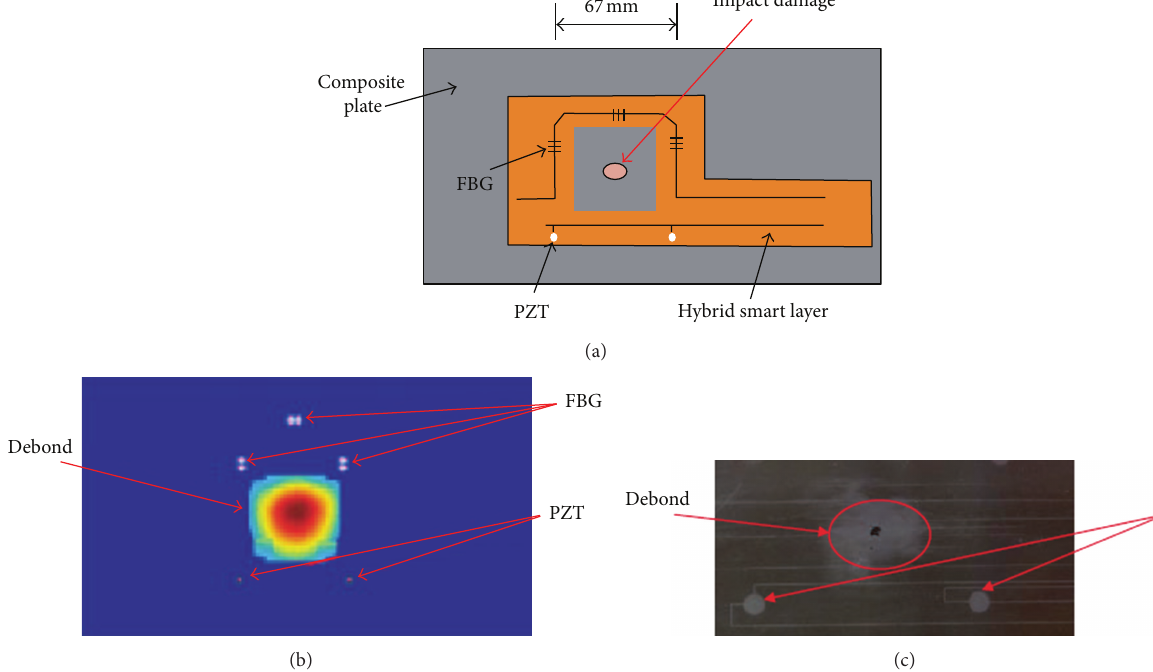
Figure 28: Hybrid sensor network used for damage detection. (a) Hybrid layer mounted on the surface of a composite panel; (b) diagnostic image of debond on the composite plate; (c) X-ray image of the damage